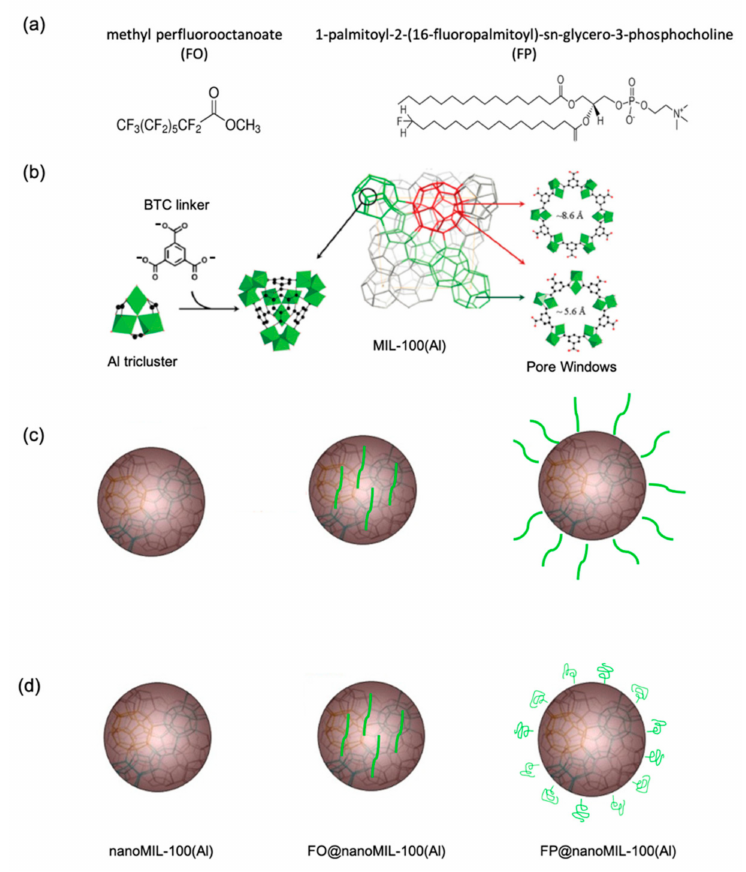
Figure 11. ( a ) Chemical structure of methyl perfluorooctanoate FO (middle) and 1-palmitoyl-2-(16- fluoropalmitoyl)-sn-glycero-3-phosphocholine FP (right). ( b ): Structure of MIL-100 (Al) based on the association of BTC linker and Al triclusters. The pore openings are shown on the right part. ( c ): Schematic structure of nanoMIL-100(Al) (left) and hypothesized localization of FO (middle) and FP (right) inside and outside the nanoMOFs, respectively. ( d ) Schematic structure of nanoMIL-100 (left) and localization of FO (middle) and FP (right) inside and outside the nanoMOFs, respectively, as deduced from the NMR data